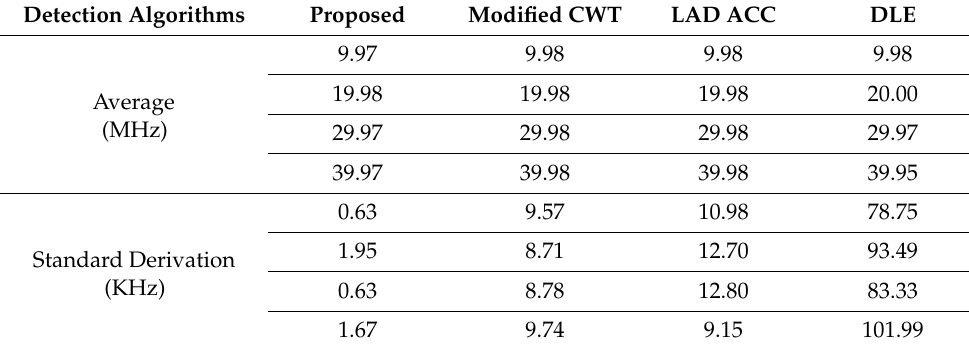
Table 3. Results of the carrier-frequency estimation accuracy.